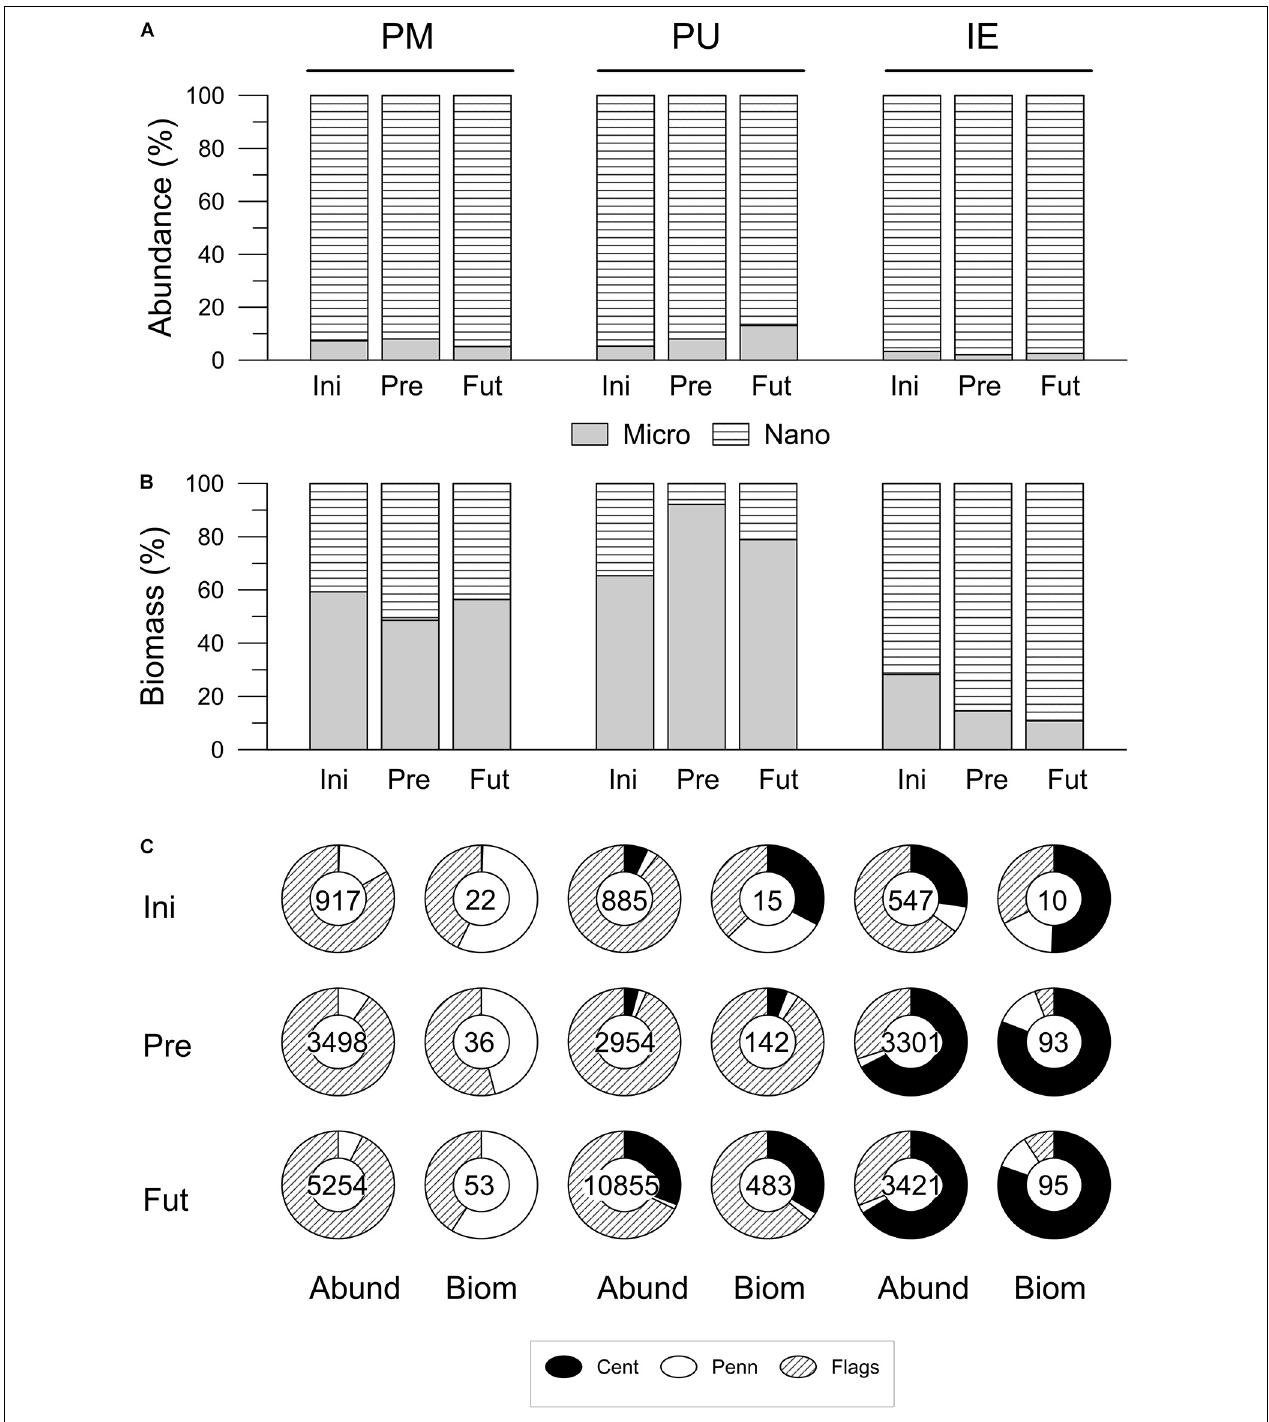
FIGURE 3 | Phytoplankton community structure: size (micro and nanoplankton) and groups (centric diatoms: Cent, pennate diatoms: Penn, and flagellates: Flags), in terms of cell abundance (A) and biomass (B) for the three studied sites–Puerto Madryn (PM), Playa Unión (PM) and Isla Escondida (IE). The data correspond to the beginning –sampling time (Ini), and after the 2 days acclimation period, for the Present (Pre) and Future (Fut) scenarios. Numbers inside the circular graphs in (C) indicate the abundance (Abund, in cells ml − 1 ) or the biomass (Biom, in µ g C l − 1 ).